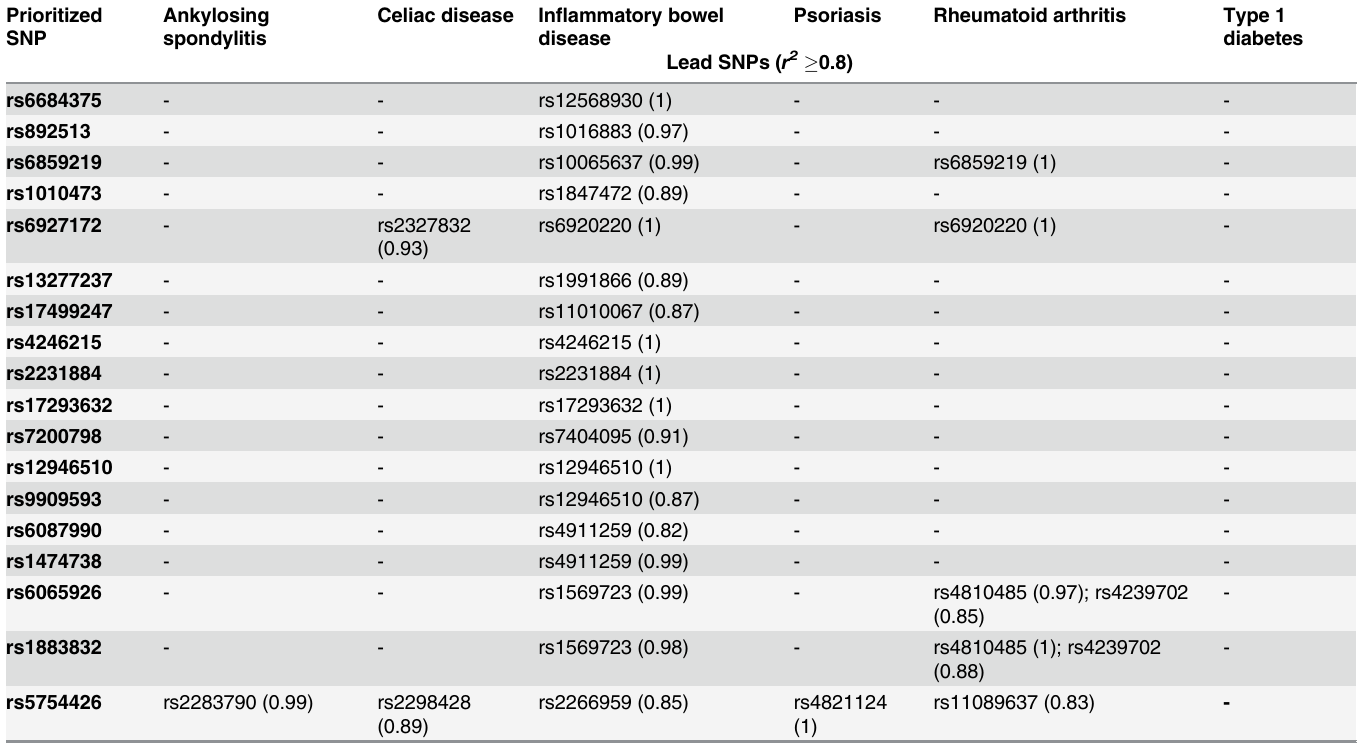
Table 4. Summary of the linkage-disequilibrium (LD) ( r 2 (cid:1) 0.8) between prioritized SNPs and lead SNPs from six immune-mediated diseases